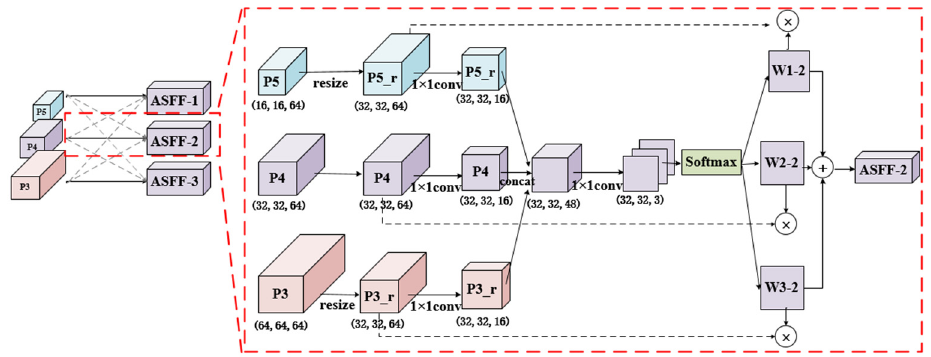
Figure 5. Schematic diagram of Adaptively Spatial Feature Fusion (Taking ASFF-2 as an example).